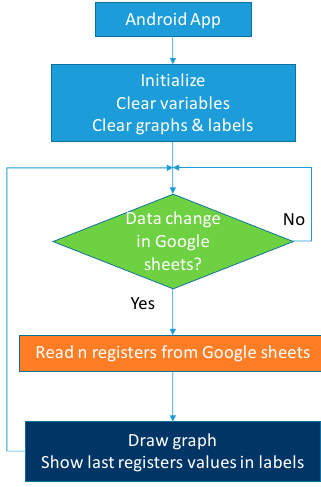
Figure 5. PFCMS Android app flow diagram .